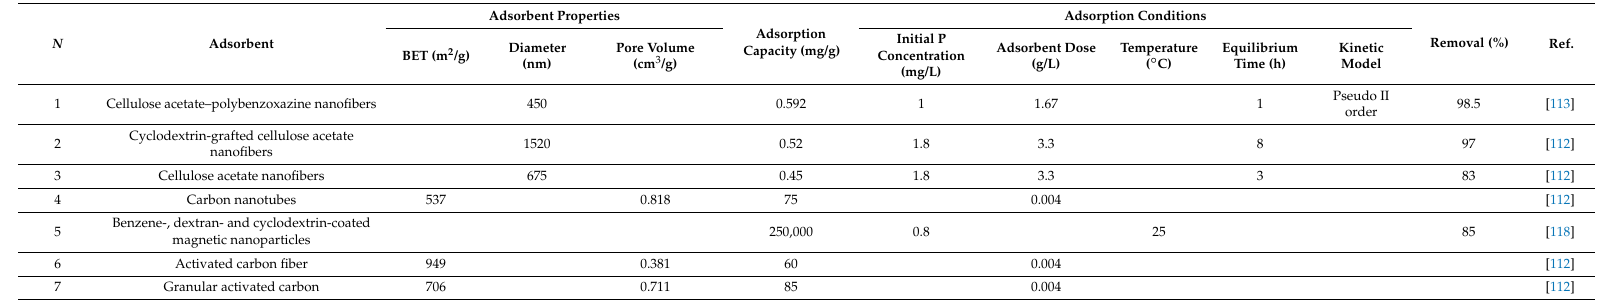
Table 20. Nanofibrous adsorbent properties and adsorption conditions for the removal of